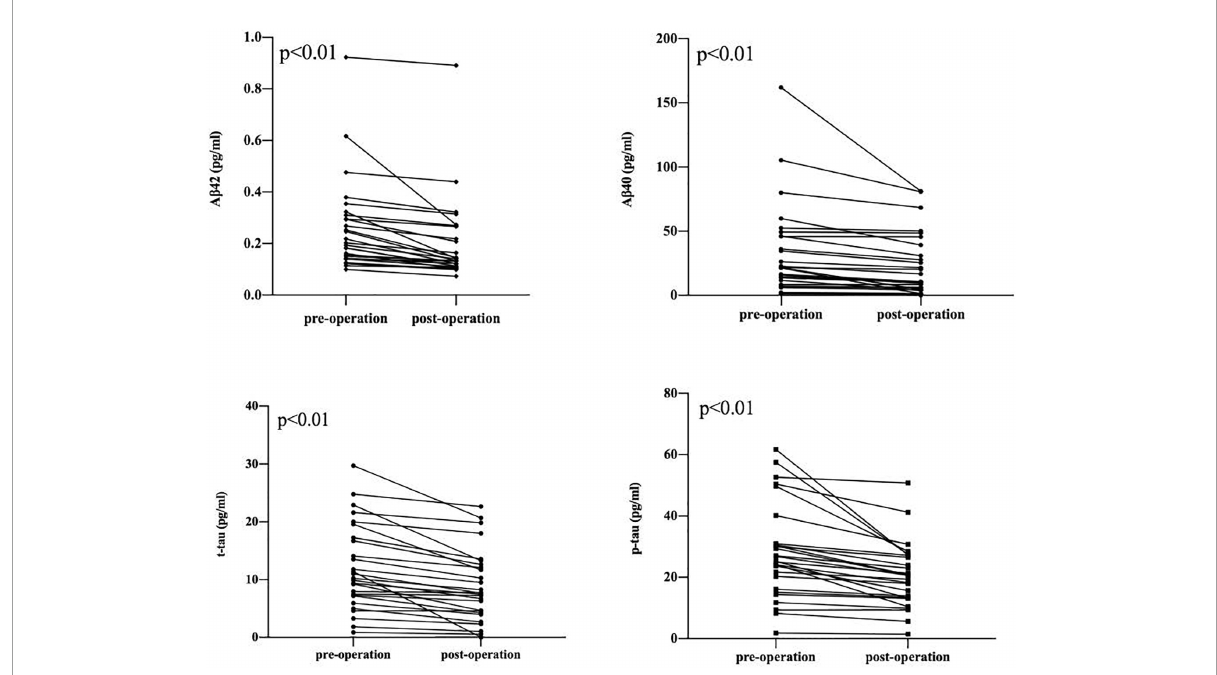
FIGURE2 Decrease in A β 42, A β 40, t-tau, p-tau between pre-operation group and post-operation group. The symbols • and (cid:5) represent the value of the patient’s